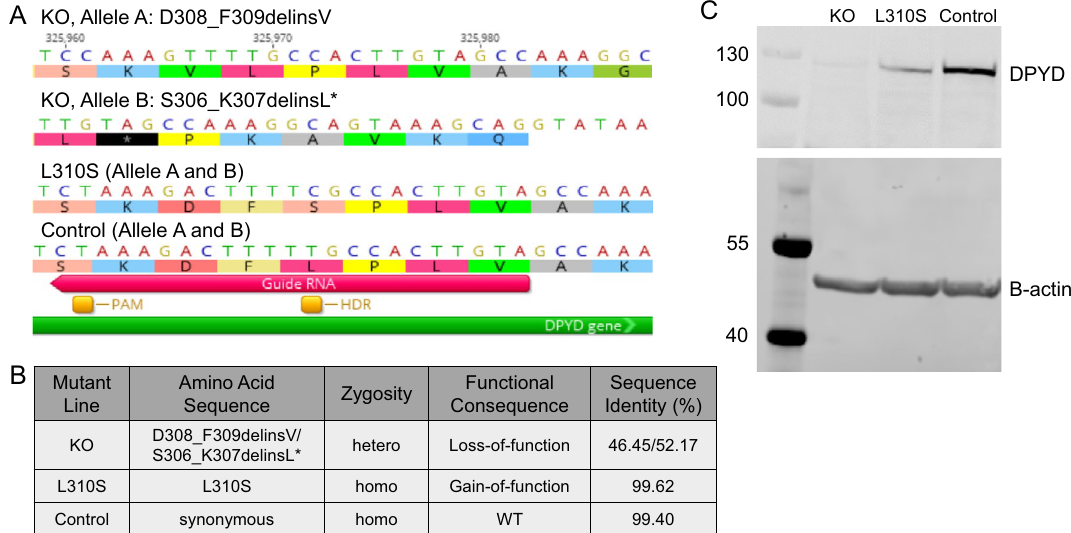
Figure 7. CRISPR-Cas9 engineered SNU449 mutant line characterization. ( A ) Genotype of three mutant SNU449 lines; Knock-out (KO) mutant line generated through NHEJ and L310S line and synonymous PAM edited control line both generated through homology-directed repair. Site of PAM sequence edit, site of non- synonymous HDR edit for L310S generation and Guide RNA sequence highlighted for reference. ( B ) Miseq targeted amplicon genotyping reveal homozygosity of L310S mutant and control line with 99.62 and 99.40% sequence identity, respectively, with reference sequence described in tile A. KO mutant line demonstrates heterozygosity with 46.45% sequence identity with allele A (D308_F309delinsV) and 52.17% sequence identity with allele B (S306_K307_delinsL*). ( C ) Western blotting describes loss-of DPYD protein expression in KO line. L310S line demonstrates reduced DPYD protein expression relative to control. Equal protein loading demonstrated through β-actin expression. Images for DPYD and β-actin are both cropped from the same blot. Full images are available in Supplementary Information